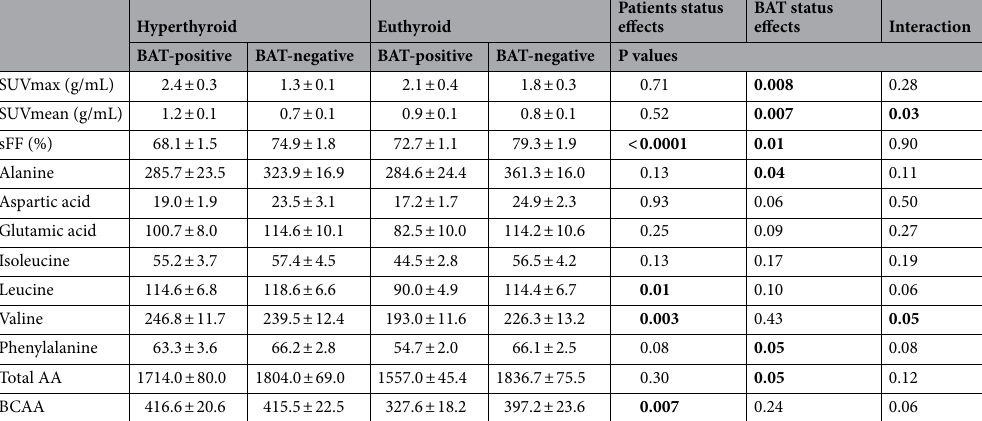
Table 5. Interaction effects between patient status (hyperthyroid and euthyroid states) and BAT status (BAT positive and BAT negative). N = 21. BAT-positive n = 8, BAT-negative n = 13. Data presented as mean ± SEM. The patients’ status effects, BAT status effects and interactions between patients’ status and BAT status were tested using linear mixed effects model adjusted by BMI. Statistically significant values are shown in bold.